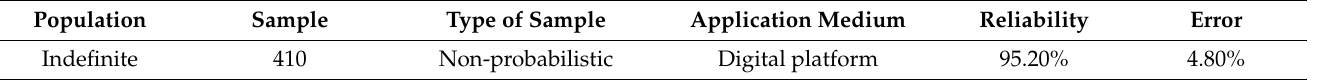
Table 2. Methodological data of the